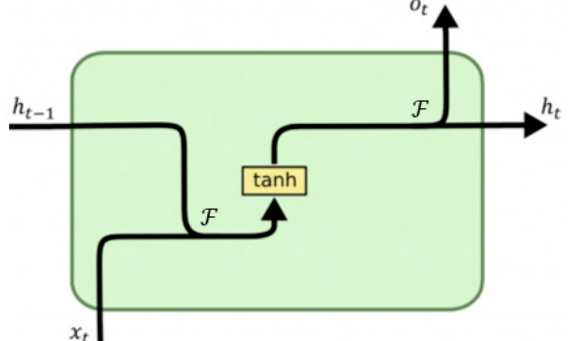
Figure 3. Typical schematic diagram of a traditional RNN node.